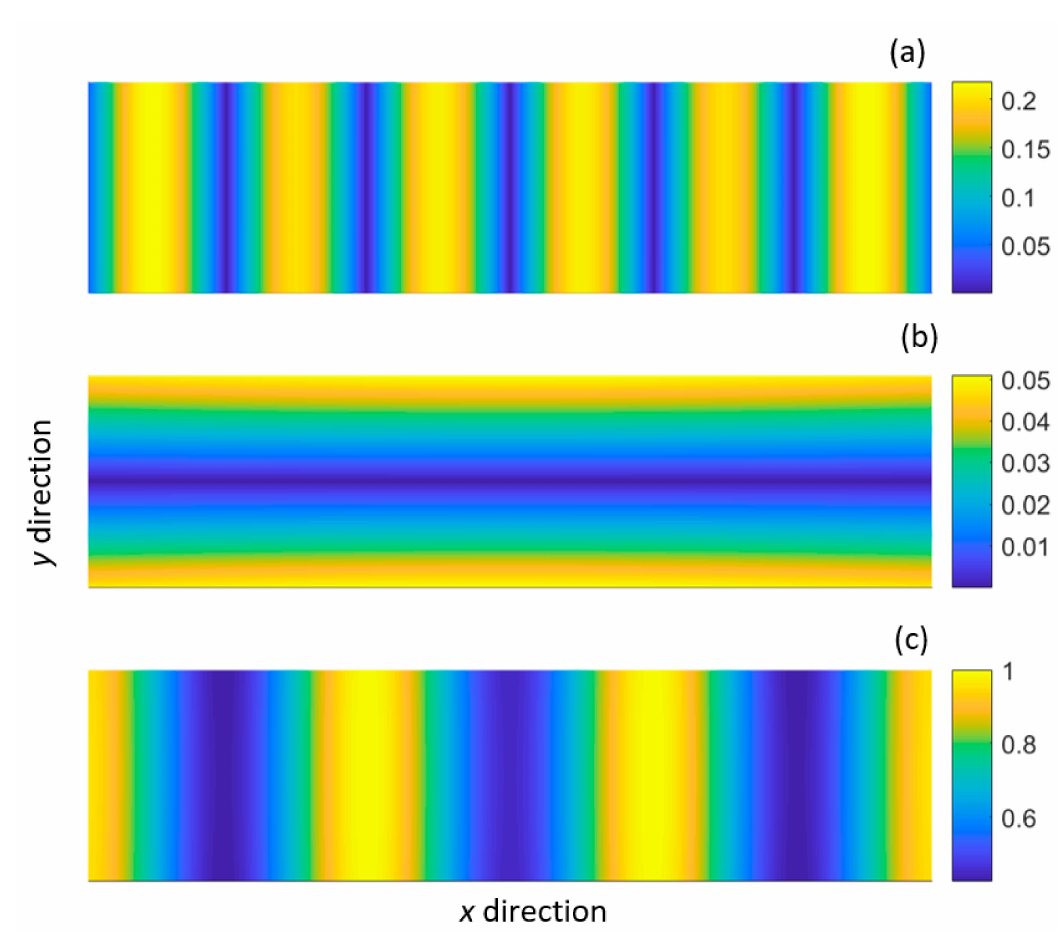
Figure 10. Normalised displacement distribution of the E1* mode: ( a ) shear displacement ( x direction); ( b ) vertical displacement ( y direction); ( c ) extensional displacement ( z